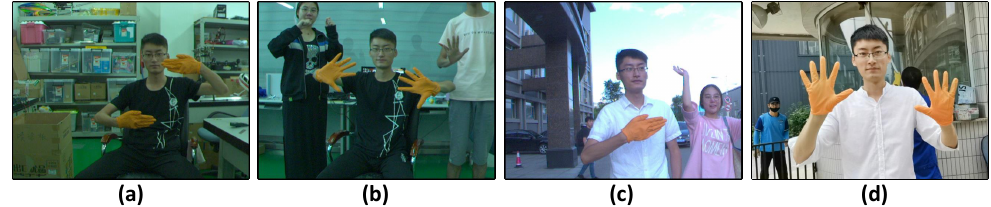
Figure 26. The noise in test dataset may degrade the performance of gesture recognition algorithms. ( a , b ) are the original depth image and corresponding binarized image in NYU dataset; ( c , d ) are the input image and segmented hand region in our dataset.